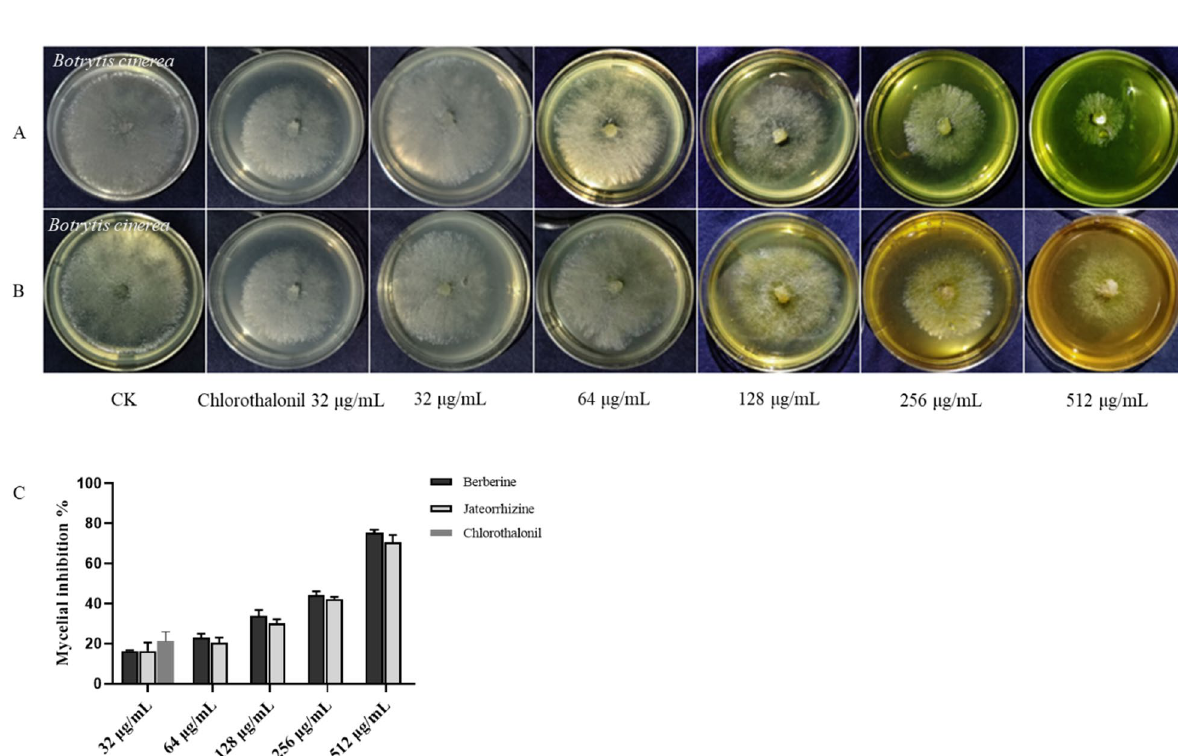
Fig. 2 The compounds inhibited mycelial growth of B. cinerea . Treatment with ( A ) berberine; ( B ) jateorrhizine; ( C ) inhibition rate of mycelia growth